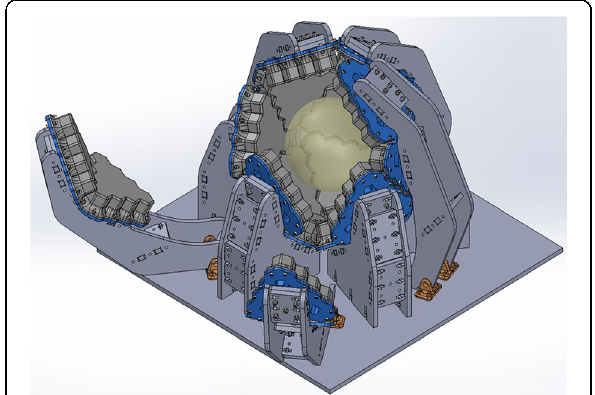
Fig. 1 (abstract A14). The scanner is formed by twenty modules arranged on ten sectors of two facets, half of them supported by hinges (orange); those sectors are moved by electromechanical actuators (not shown) to open the scanner. The yellow sphere represents the